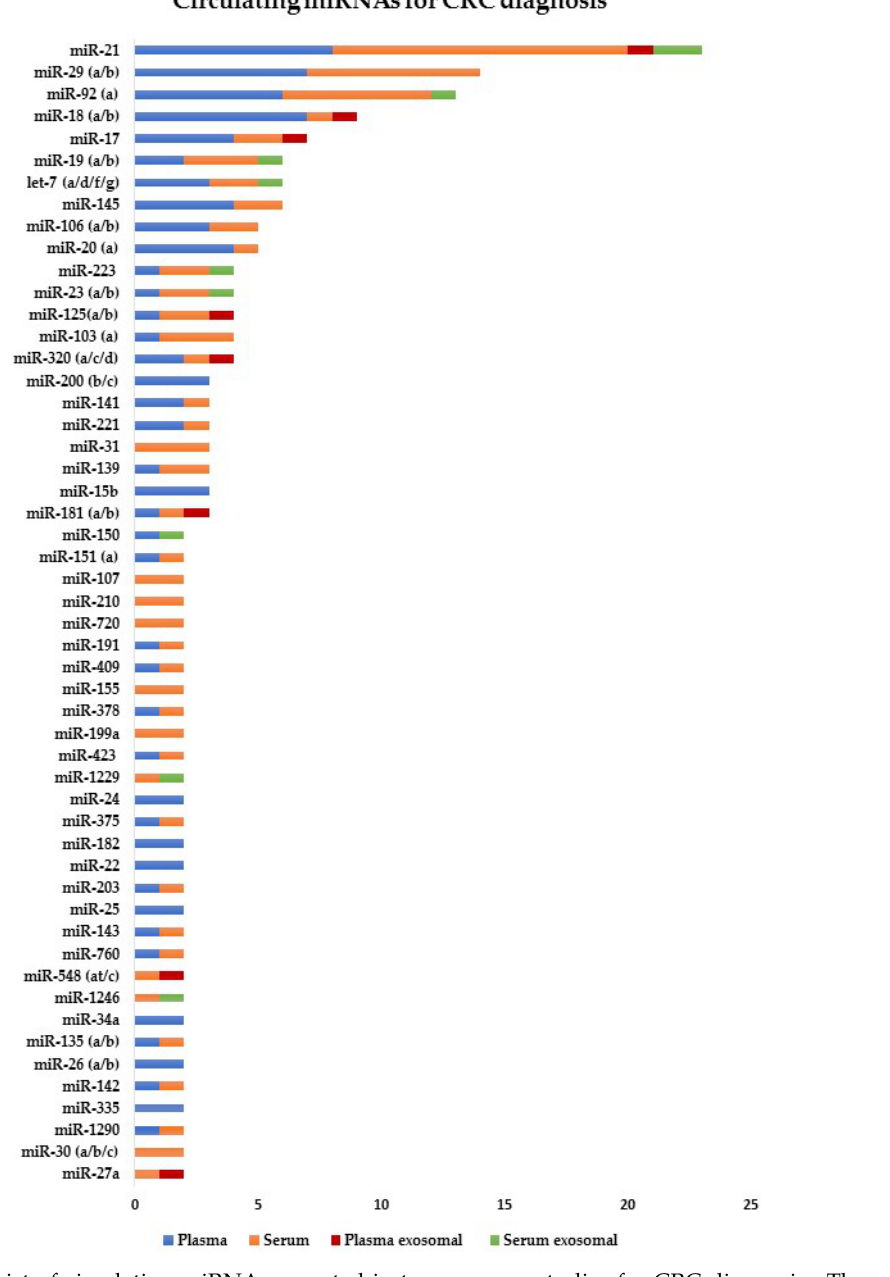
Figure 2. List of circulating miRNAs reported in two or more studies for CRC diagnosis. These miRNAs were significantly deregulated in CRC compared to healthy individuals ( p < 0.05). References are provided in Table